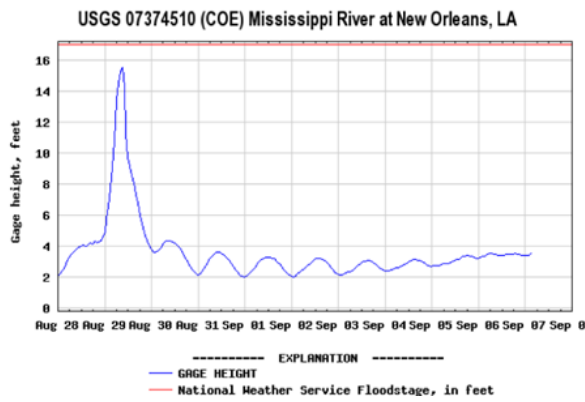
Figure 3. Stage gage reading in the Mississippi River at New Or- leans during Hurricane Katrina, demonstrating the increase in stage due to storm surge (Rivergages,